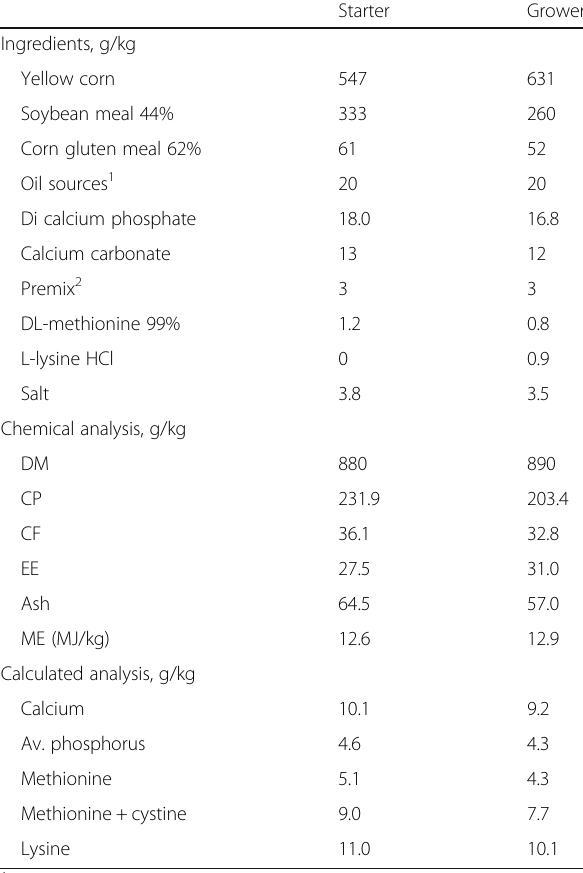
Table 1 Ingredients and chemical composition of basal